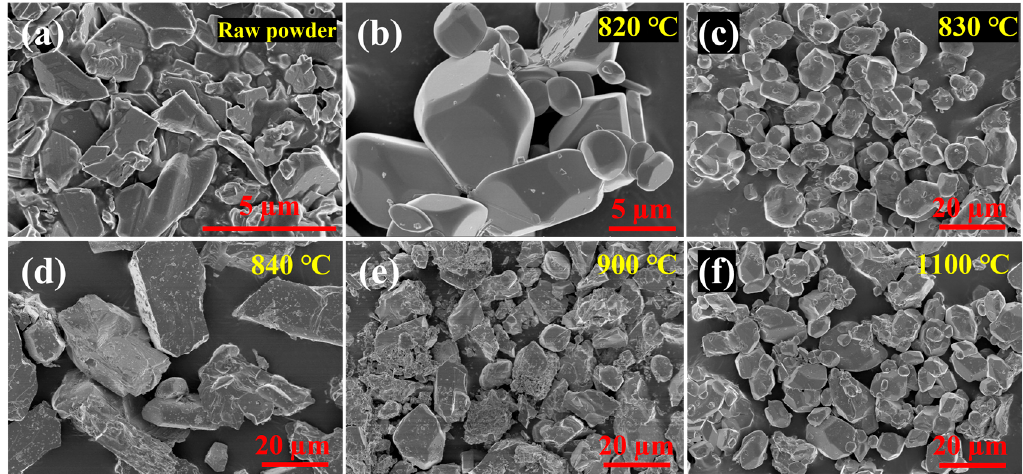
Figure 8. Surface morphologies of the Mo 4 O 11 raw powders ( a ) and them after heat treated at 820 °C ( b ), 830 °C ( c ), 840 °C ( d ), 900 °C ( e ) and 1100 °C ( f ) for 1 h in fl owing